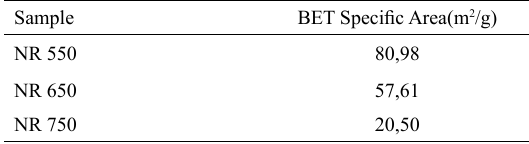
Table 2. BET specific area for the samples NR550, NR650 and